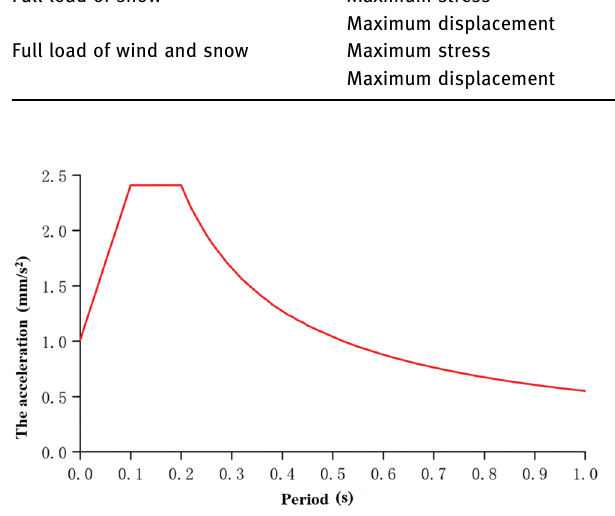
Figure 8: The seismic response spectrum